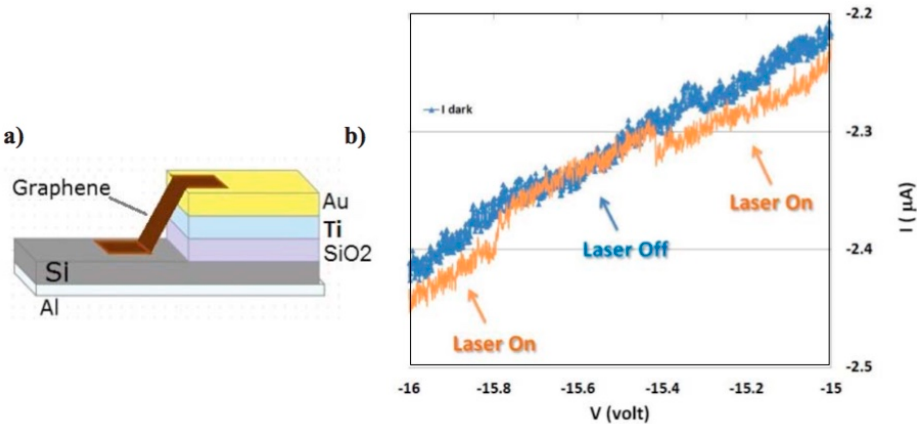
Figure 4. ( a ) Sketch describing the graphene-silicon (Si) Schottky diode investigated in Amirmazlaghani [27]. ( b ) The current-voltage I-V curve at reverse bias (from − 16 to − 15 V). This figure demonstrates the change in diode current by switching on and off the laser at 1550 nm. Reprinted with permission from (Amirmazlaghani, Raissi, Habibpour, Vukusic, Stake. Graphene-Si Schottky IR detector. IEEE J. Quant. Elect. 2013 , 49 , 2589). Copyright (2013) IEEE.